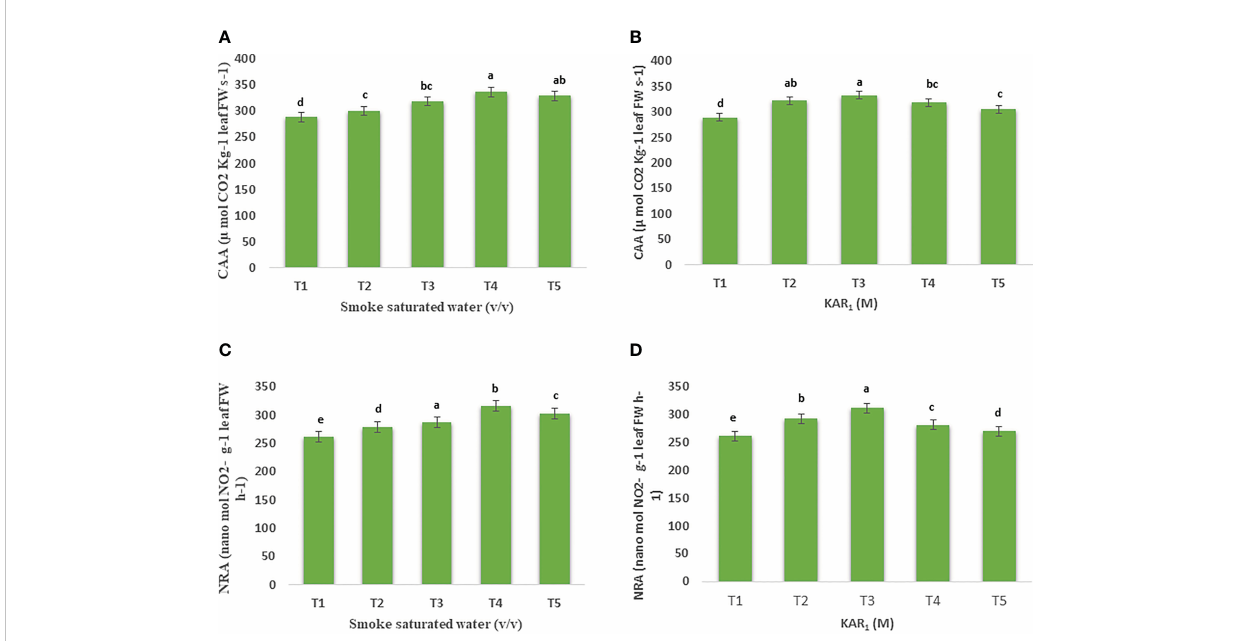
FIGURE 2 Effect offoliar application with smoke-saturated water 1:125, 1:250, 1:500, and 1:1000 v/v) and karrikinolide (10 -9 M, 10 -8 M, 10 -7 M and 10 -6 M) on carbonic anhydrase activity (µmol CO 2 Kg -1 leaf FW s -1 ) (A, B) and nitrate reductase activity (nanomol NO 2- g -1 leaf FW h -1 ) (C, D) of Mentha arvensis L. Lowercase letters depicts the Duncan. Data are presented as treatments mean ± SE (n = 5). Data followed by the same letters are not signi fi cantly different by Duncan multiple range test at p ≤